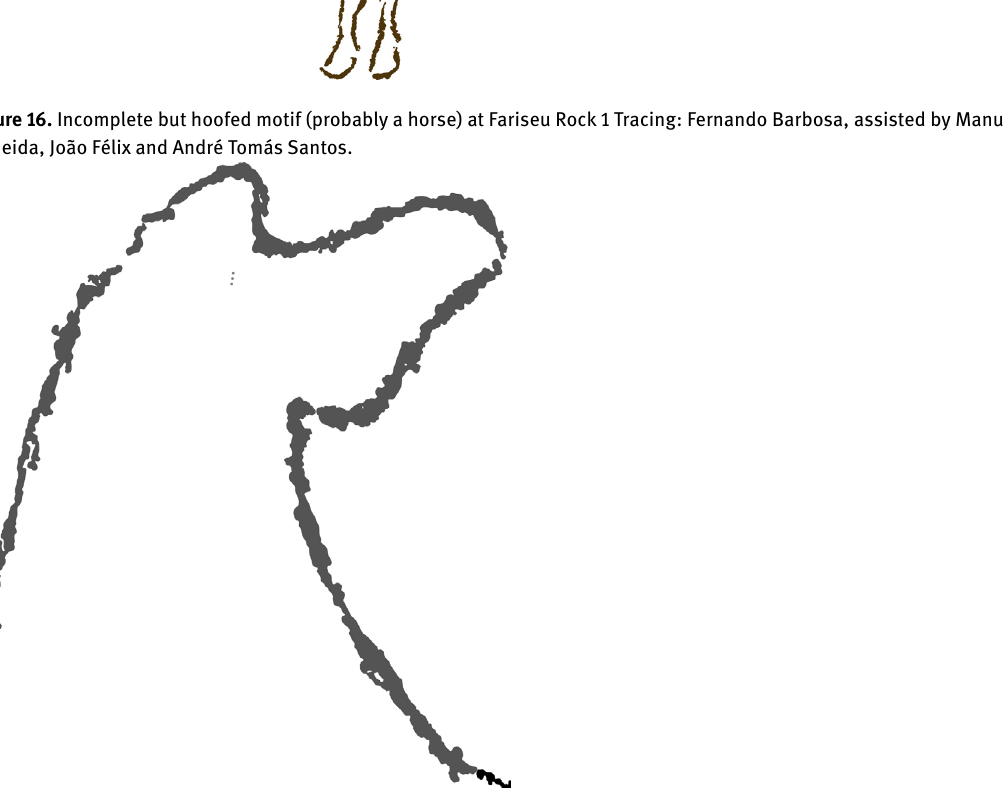
Figure 17. Depiction of a horse’s head and neck in Penascosa Rock 3. As in Figure 2 note the shape of the animal’s head and the well-defined mane. Tracing: António Martinho Baptista, Fernando Barbosa and Mário Varela Gomes, assisted by Manuel Almeida, João Félix and Cristina